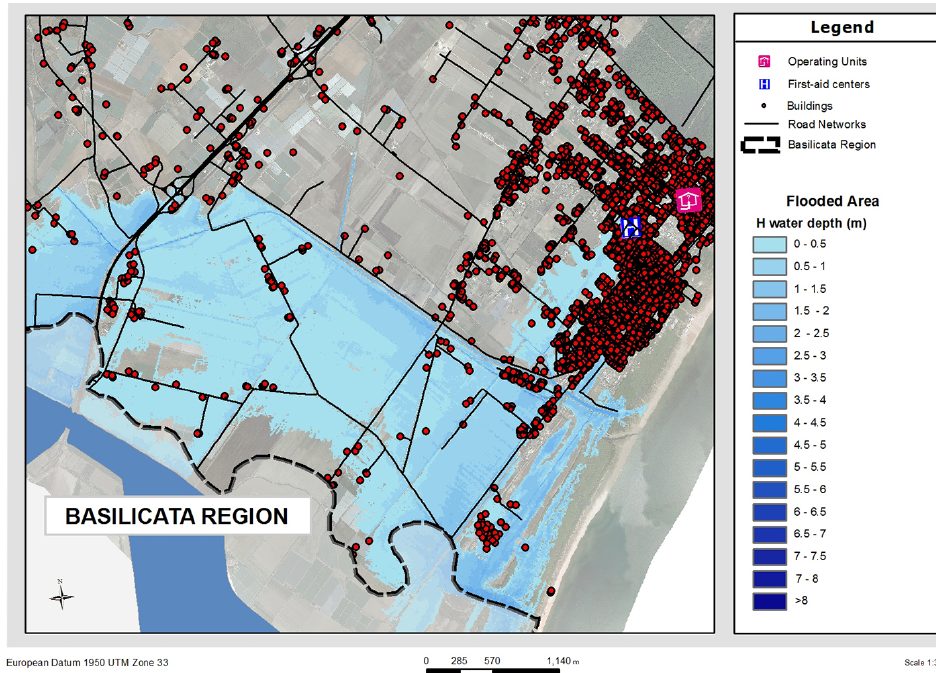
Figure 9. Water depth, H , from hydraulic modelling